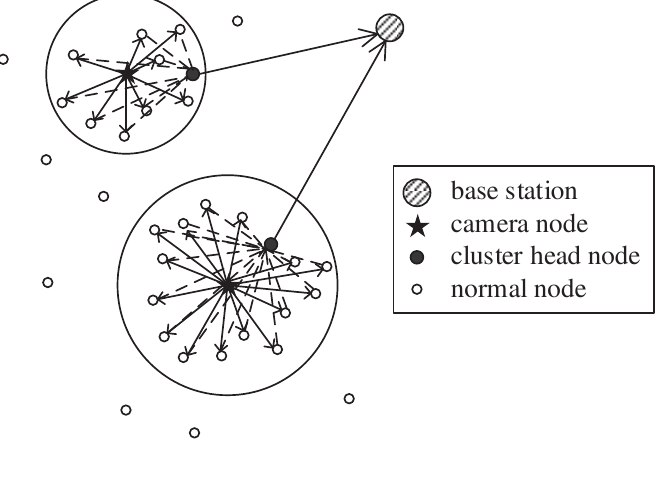
Figure 1. Network